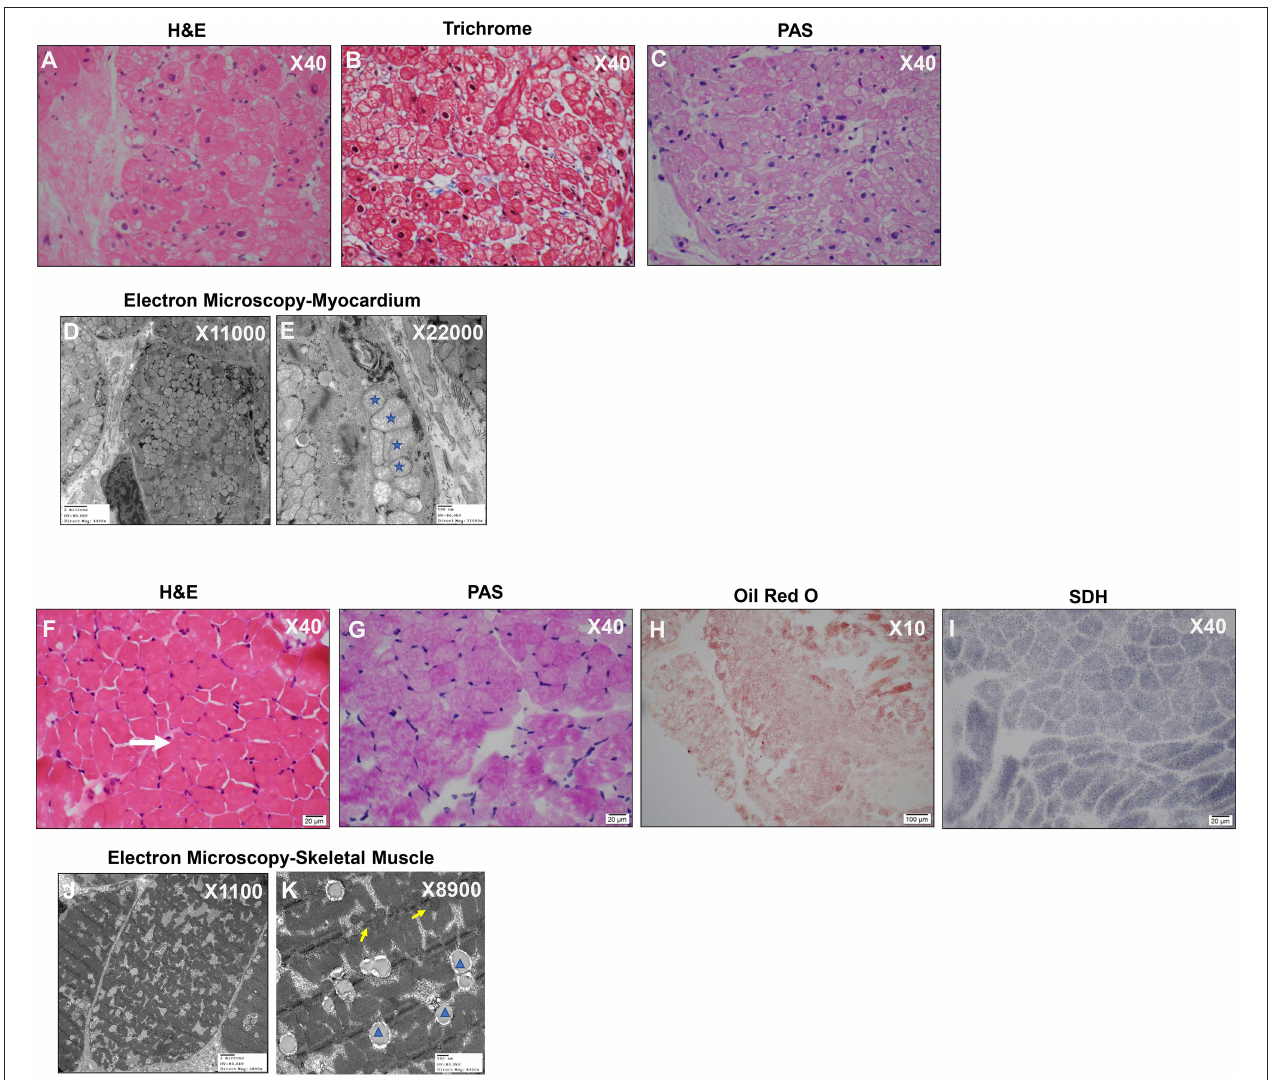
FIGURE 2 | Myocardium and Skeletal Muscle Biopsies Reveal Hyperplastic and Polymorphic Mitochondria and Lipid Accumulation. (A) Myocardium: H&E X40 shows diffuse generalized granular vacuolization likely representing mitochondria. (B) Myocardium: Mason Trichrome X40 reveals minimal fibrosis. (C) Myocardium: Periodic Acid Schiff (PAS) X40 Negative staining indicates absence of abnormal glycogen content. (D,E) Myocardium: Electron microscopy– myocardium X11000 (D) and X22000 (E) : Mitochondrial hyperplasia, pleoconia, and megaconial forms and loss of internal cristae; Stars indicate mitochondria of variable and abnormal size. (F) Skeletal Muscle: H&E X40 Moderate fiber size variation with occasional atrophic fibers (white arrow). No evidence of degeneration/regeneration/inflammation. (G) Skeletal Muscle: PAS X40 Mild glycogen accumulation. (H) Skeletal Muscle: Oil Red O X10 Increased cytoplasmic lipid. (I) Skeletal Muscle: SDH X40 complex II mitochondrial respiratory chain enzyme-normal appearance. (J,K) Electron microscopy-skeletal muscle direct magnification of X11000 (J) and X8900 (K) : Mitochondria are normal in size and shape (yellow arrows); there is slight increase in cytoplasmic Glycogen (orange star) lipid (blue